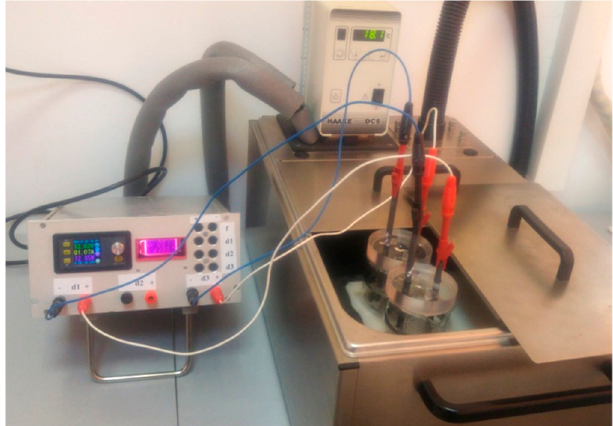
Figure 1. The experimental setup employed for the electrochemical exfoliation of graphite rods with pulses of current.